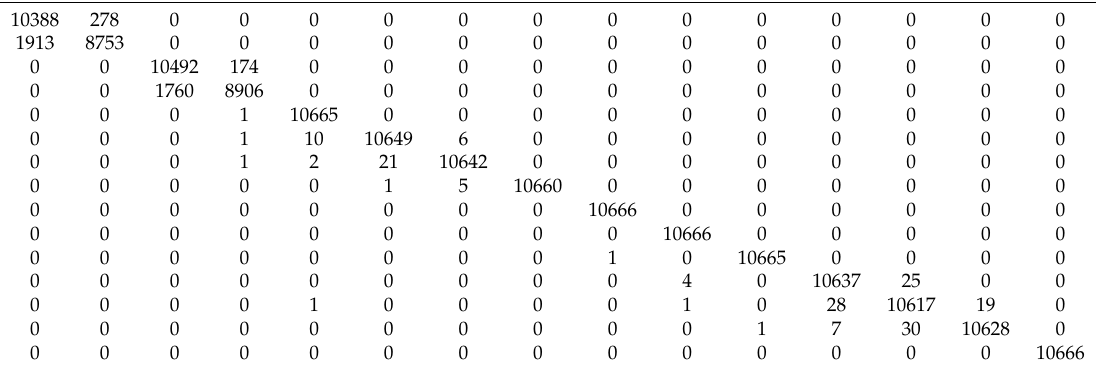
Table 4. Confusion matrix corresponding to C2R training evaluation with 10 epochs when 15 physical exercises are considered.